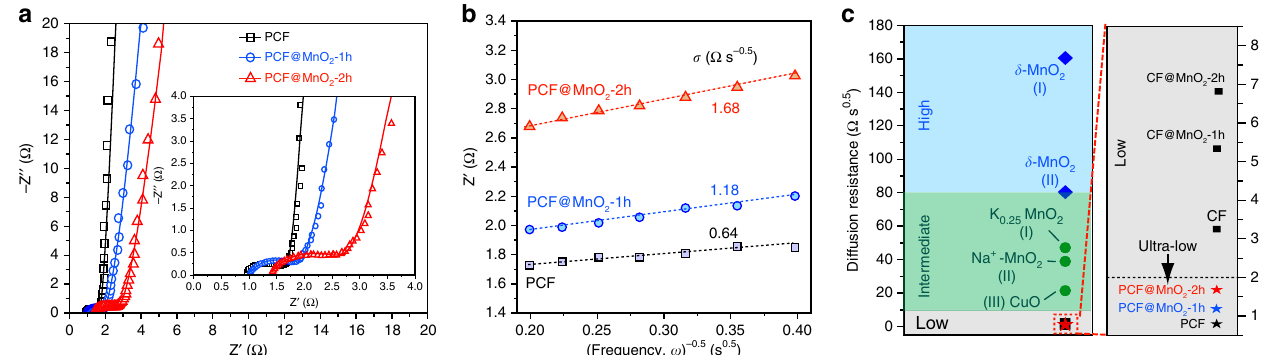
Fig. 4 Ultra-fast electron and ion transport in the PCF-based electrodes. a Nyquist plots collected at open circuit potentials with 5 mV perturbation and a frequency range from 10,000 to 0.1 Hz. The open symbols are experimental data and the solid lines are fi tting curves. b Z ’ vs. the reciprocal of the square root of frequency ( ω − 0.5 ) in the intermediate frequency range. The dashed lines are best fi tting lines to calculate the diffusion resistance, σ . c The ion diffusion resistance of the carbon fi ber electrodes in comparison with other reported electrodes: (I) Ref. 57; (II) Ref. 58; (III) Ref. 59. The CF-based electrodes show low diffusion resistance and the PCF-based electrodes show ultra-low and 6.8 ± 0.4 mg cm − 2 , respectively. The error bars ( ± values) are